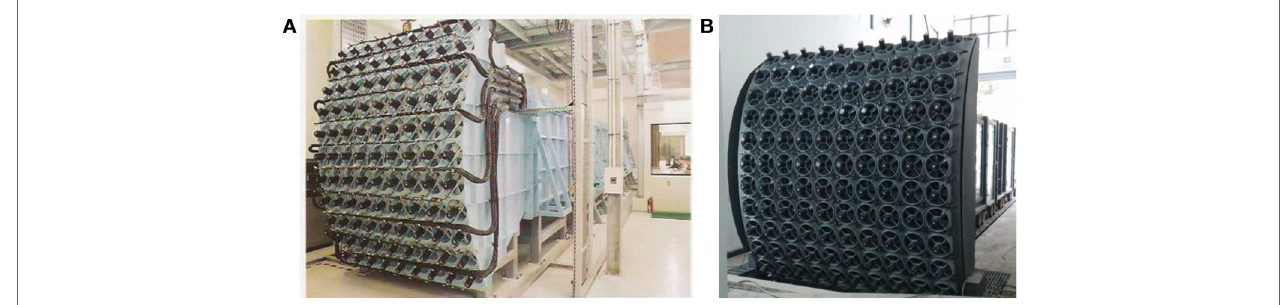
FigUre 1 | Multiple-fan wind tunnels. (A) Miyazaki University tunnel (99 fans). (B) Tongji University tunnel (120